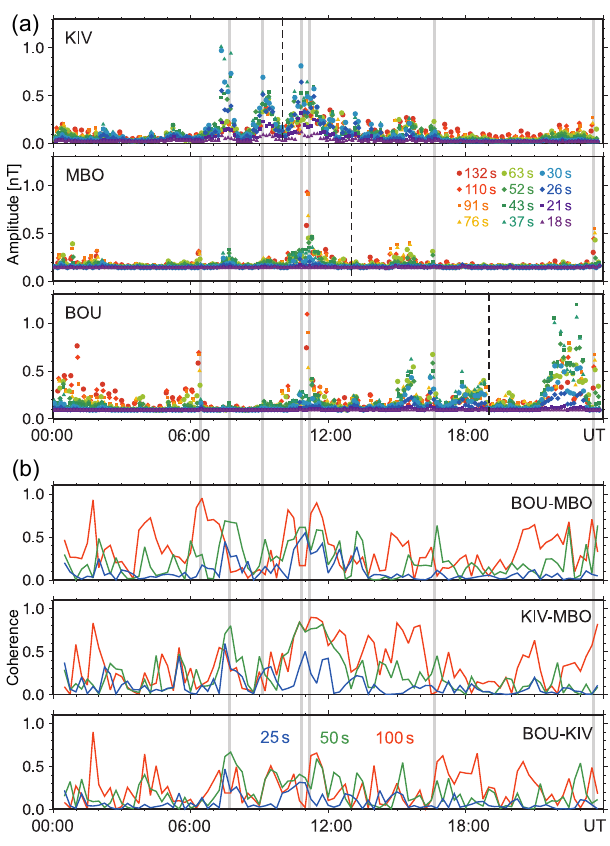
Figure 4. Dynamic amplitude spectra of (a) and coherences be- tween (b) H components of KIV, MBO, and BOU observatories for 4 March 2013, for a number of pc3–4 periods. Although the main activity takes place around local noon (marked with vertical dashed lines in a ), many events take place synchronously in these distant places, and often short-term coherence (time resolution: 15min) is not low. Such events are marked with grey vertical